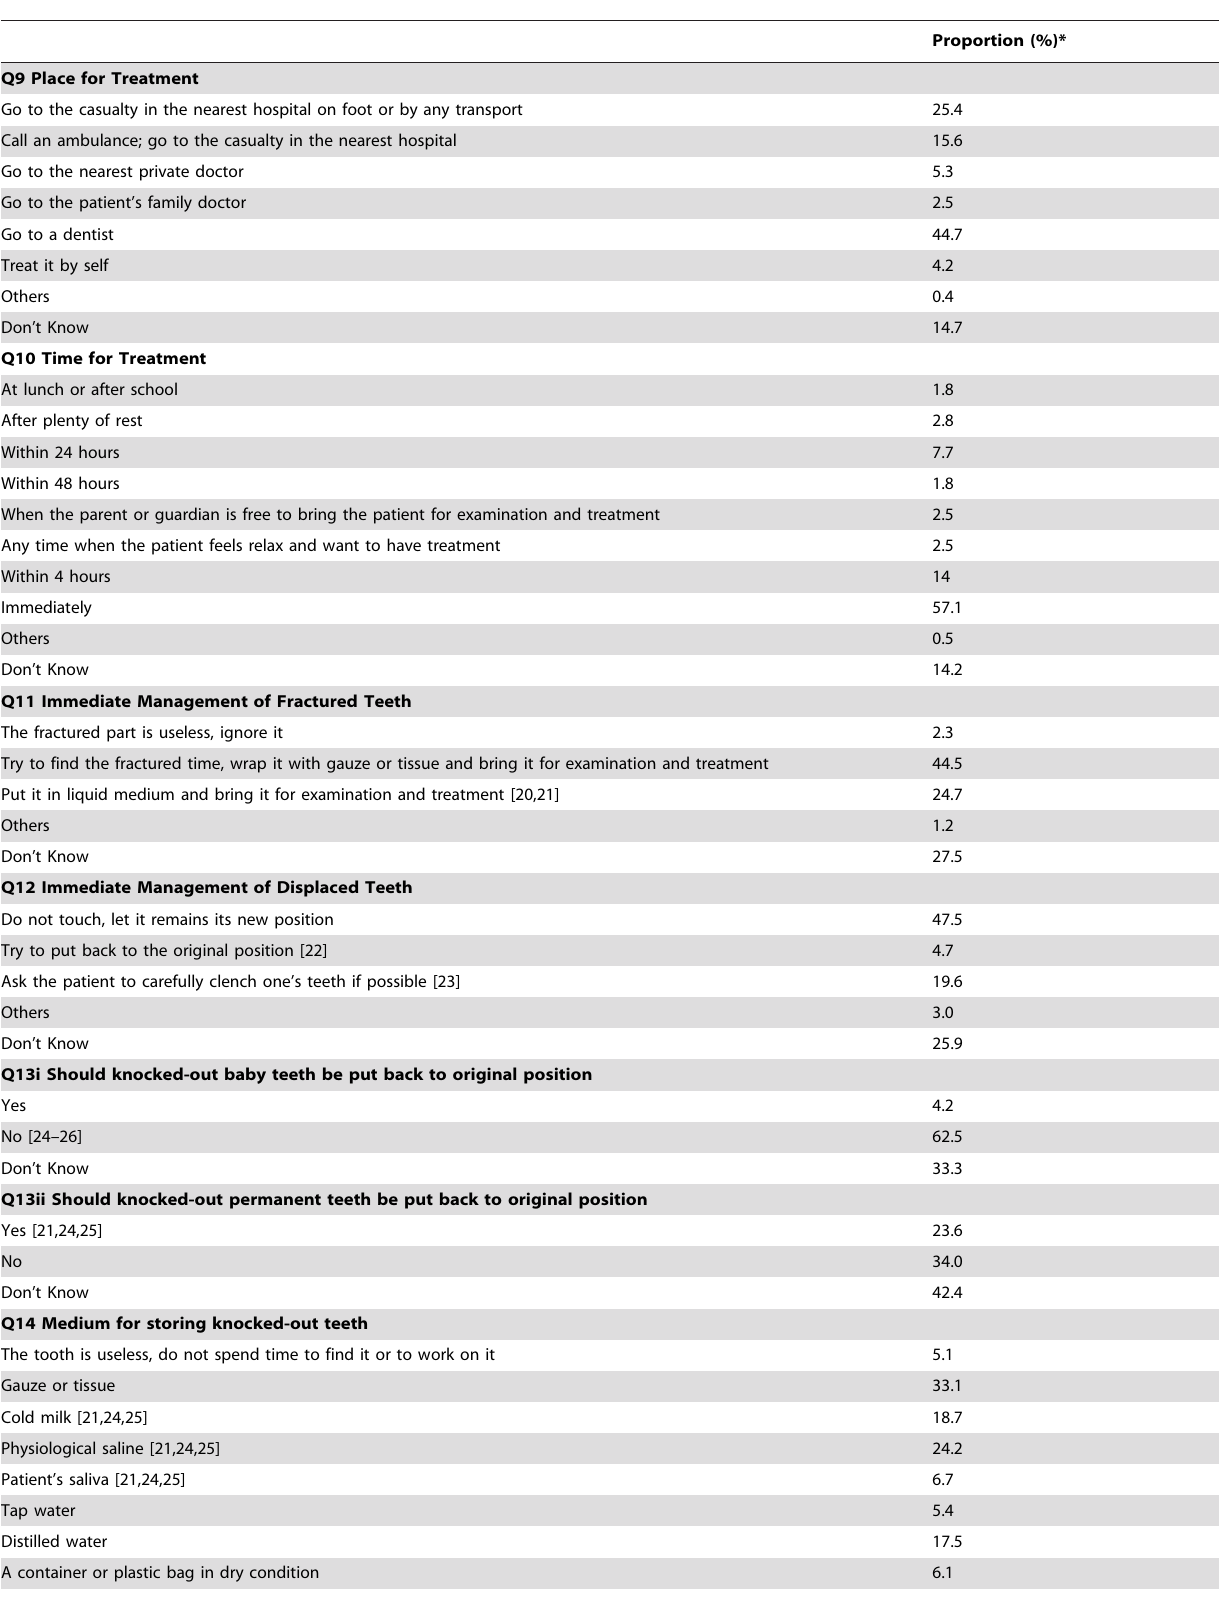
Table 3. Options chosen in knowledge